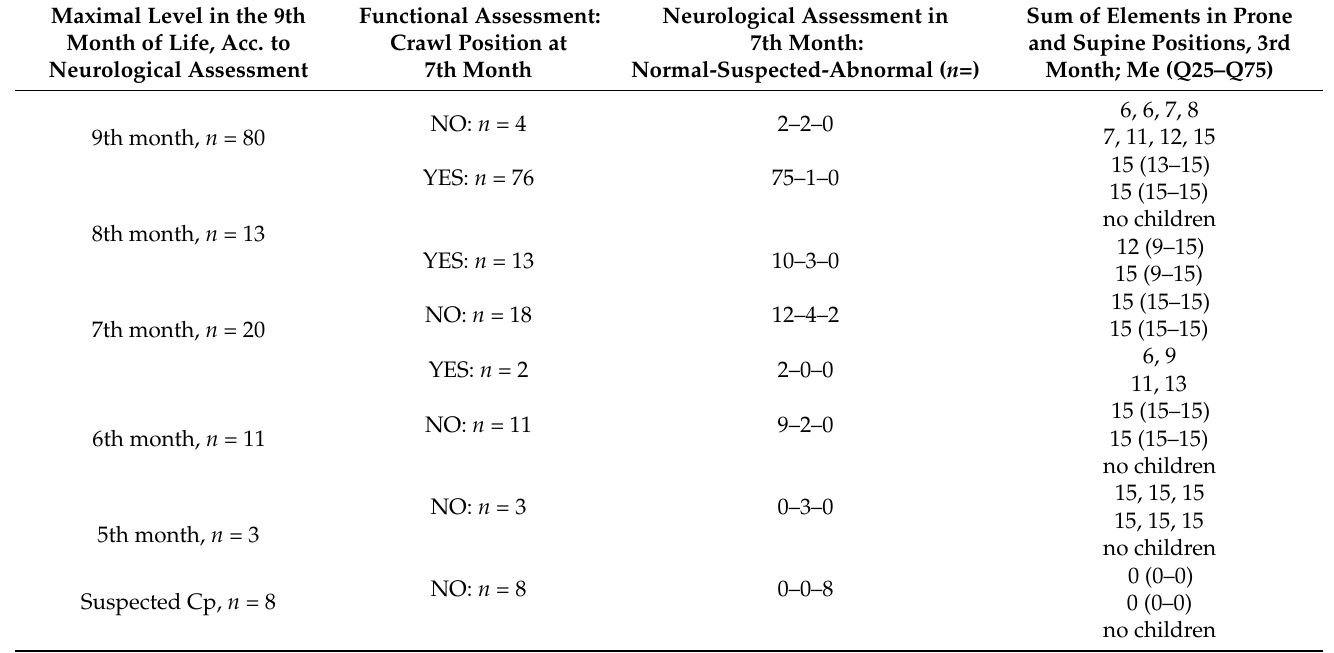
Table 4. All investigated children were classified according to the maximal developmental level, acc. to neurological investigation in the 9th month. In the second column is the number of children who did or did not achieve the crawl position in the 7th month. In the third column is the number of children classified by the neurologist in the 7th month as normal, suspected or abnormal. In the last column are the median and quartiles of the qualitative examination in the 3rd month, in the prone and supine positions are given. If the number of children was below 7, particular results, not median, are